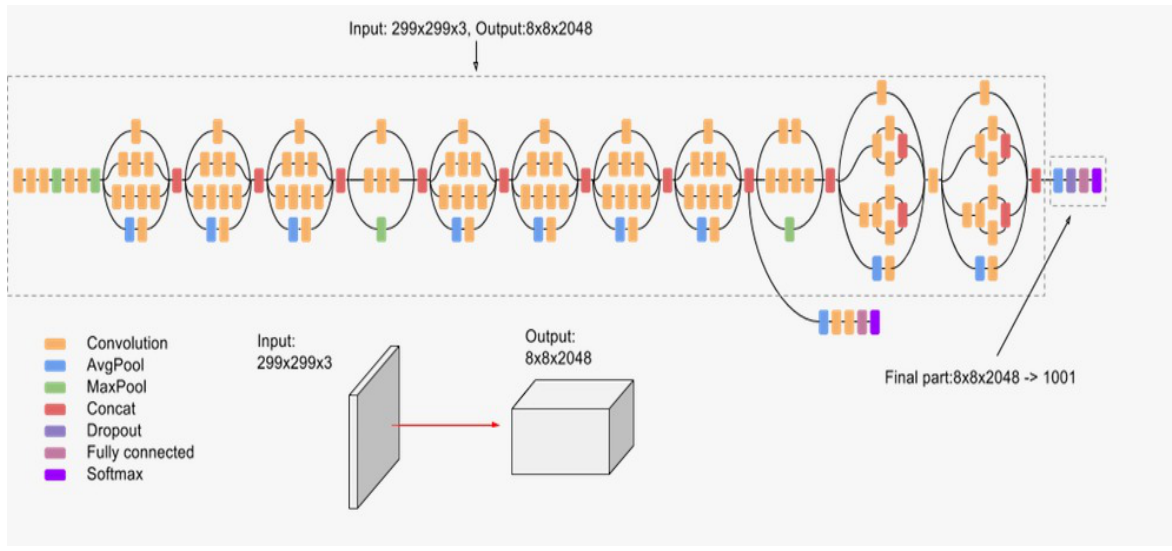
Figure 9. Inception